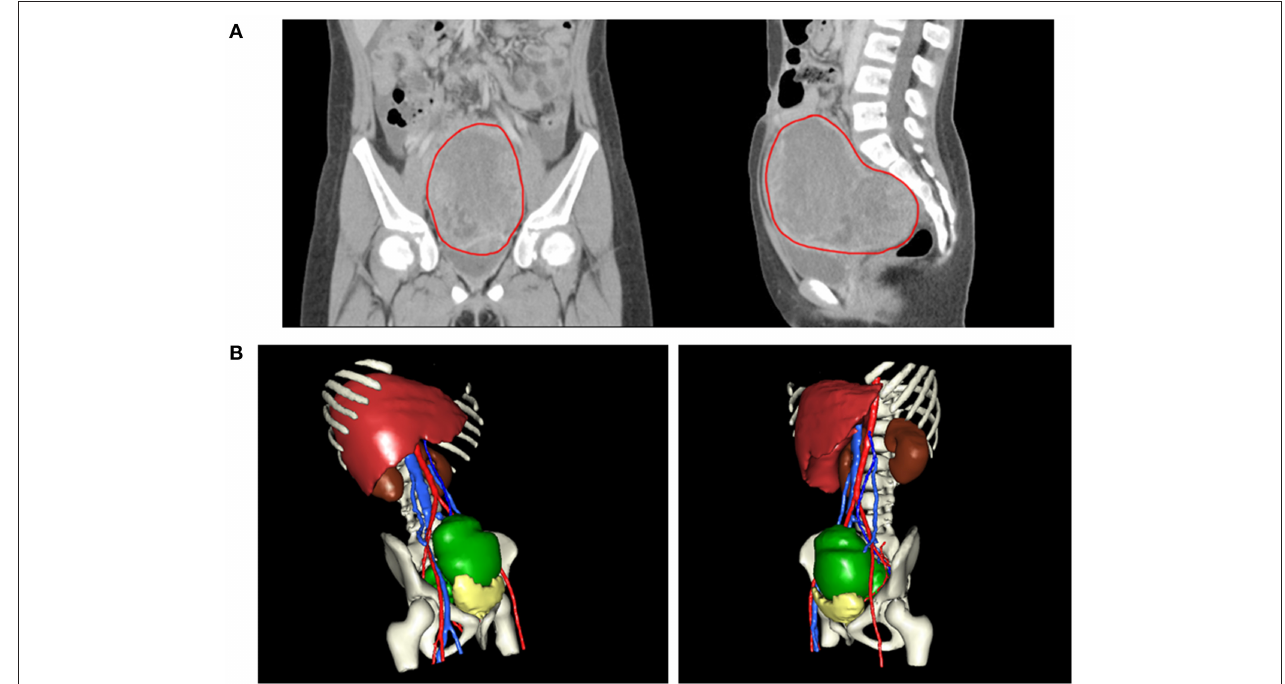
FIGURE 1 | (A) CT revealing a large pelvic mass measuring 12 × 9.7 × 7.38cm in size (circled by red line). (B) A three-dimensional virtual model created from 1.25-mm thin-slice CT images showing the tumor of 12 × 9.7 × 7.38cm in size